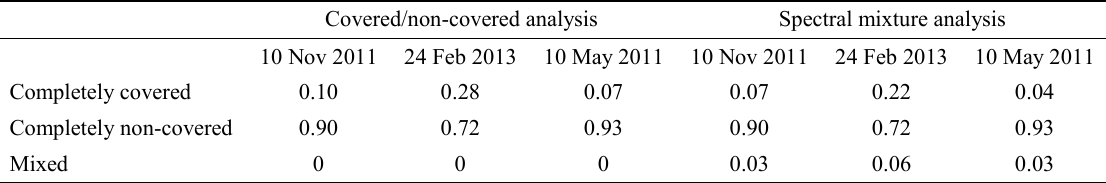
Table 1 Fraction values of each type of area considered in the analysis (completely covered, completely non-covered and mixed) obtained from both algorithms for the 10 Nov 2011, 24 Feb 2013 and 10 May 2011 Landsat TM